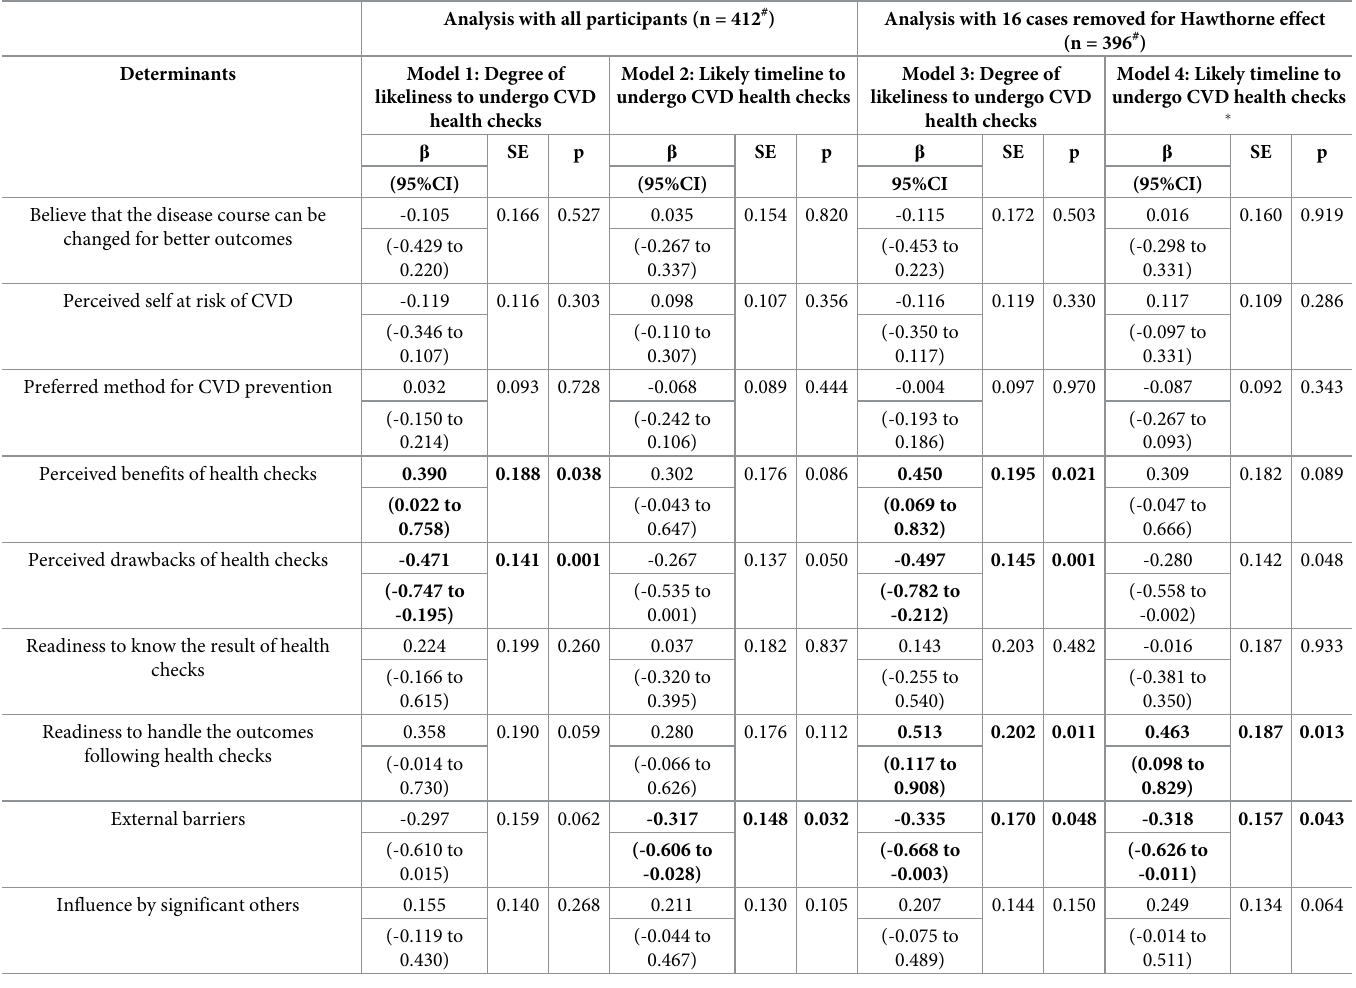
Table 4. Determinants of individuals’ intention to undergo health checks adjusted for sociodemographic